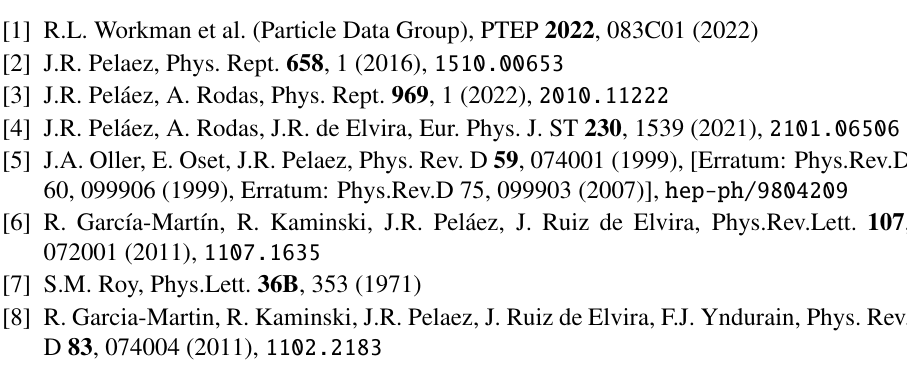
Figure 10. Present situation of T -matrix poles of light scalars in the RPP [1]. The grey areas cover the RPP estimates for each resonance pole mass and width, where highlighted in red the "Roy-like" dispersive determinations. Note that poles for traditional Breit-Wigner parameterizations, highlighted in blue, are also listed since they are still widely used, although they are not appropriate for these poles. Left: for the σ/ f 0 (500) meson. Center: for the strange κ/ K ∗ resonance. Right: For the f 0 (980), which has never been too controversial, but can also be determined dispersively. Original figures taken from [1]. The highlighting and commenting of red and blue areas is